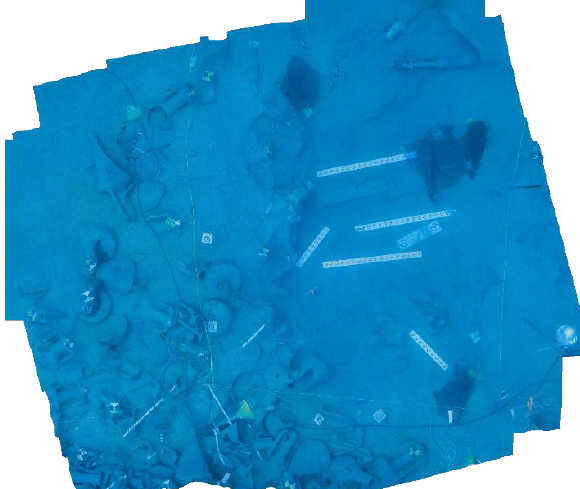
Figure 1: Orthophoto from original dataset without radiometric corrections.